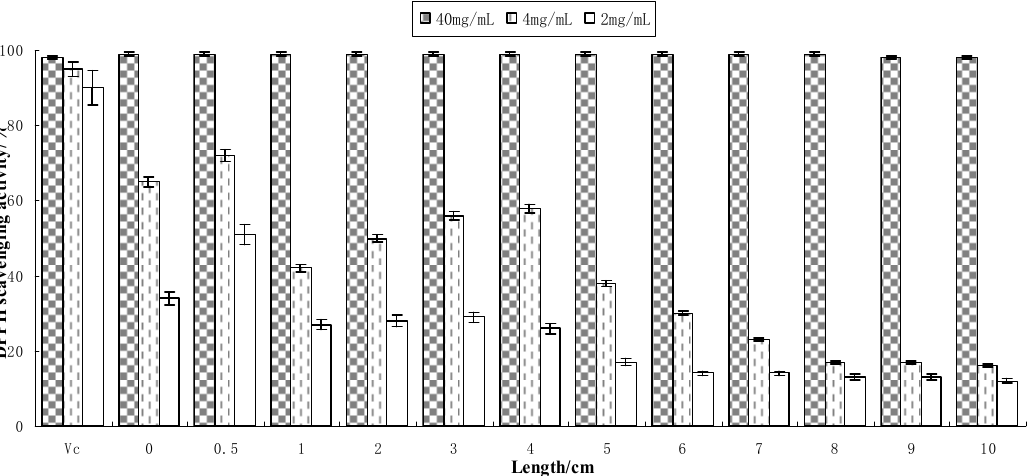
Figure 2. Anti-oxidizing capacity of extracts obtained from different lengths of bean sprouts (n =